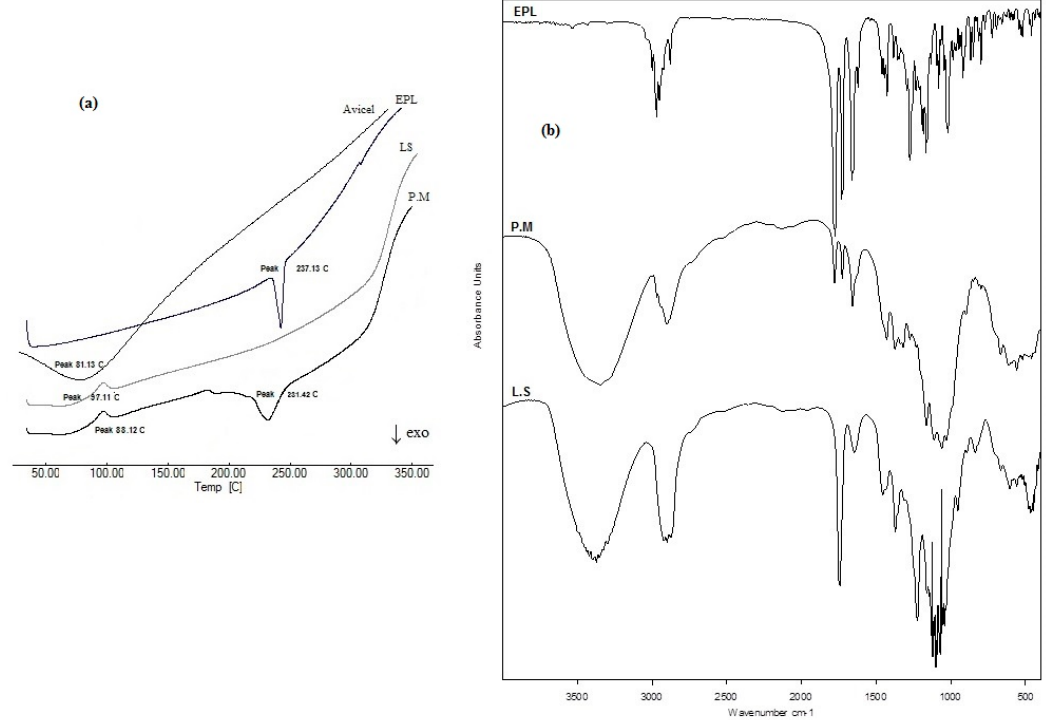
Figure 4. Solid state characterization of EPL-NE liquisolid formulation using ( a ) differential scanning calorimetry (DSC) and ( b ) FTIR.